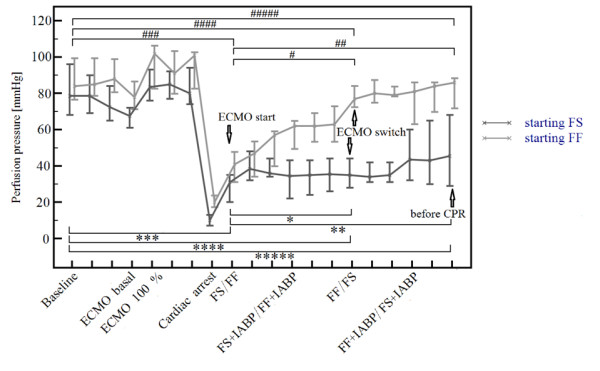
Coronary perfusion pressure progression over time and differences in respective ECMO approaches according to randomization. Values in bold mean statistically significant difference. The pressure differences between the respective arms on "ECMO start", "ECMO switch" and "before CPR" are 10, 42 and 40.5 mmHg, respectively, see Table 3 for absolute values (P = 0.193 for "ECMO start", P = 0.045 for "ECMO switch" and P = 0.008 for "before CPR" values). Statistical evaluation for CoPP progression within the respective arms is delineated by horizontal bars with statistical evaluation as follows. P-values for FF arm: #####P = 0.7;####P = 0.39; ### P = 0.002; ##P = 0.006; #P = 0.02. P-values for FS arm: *****P = 0.041, ****P = 0.004, ***P < 0.001, **P = 0.11, *P = 0.49.